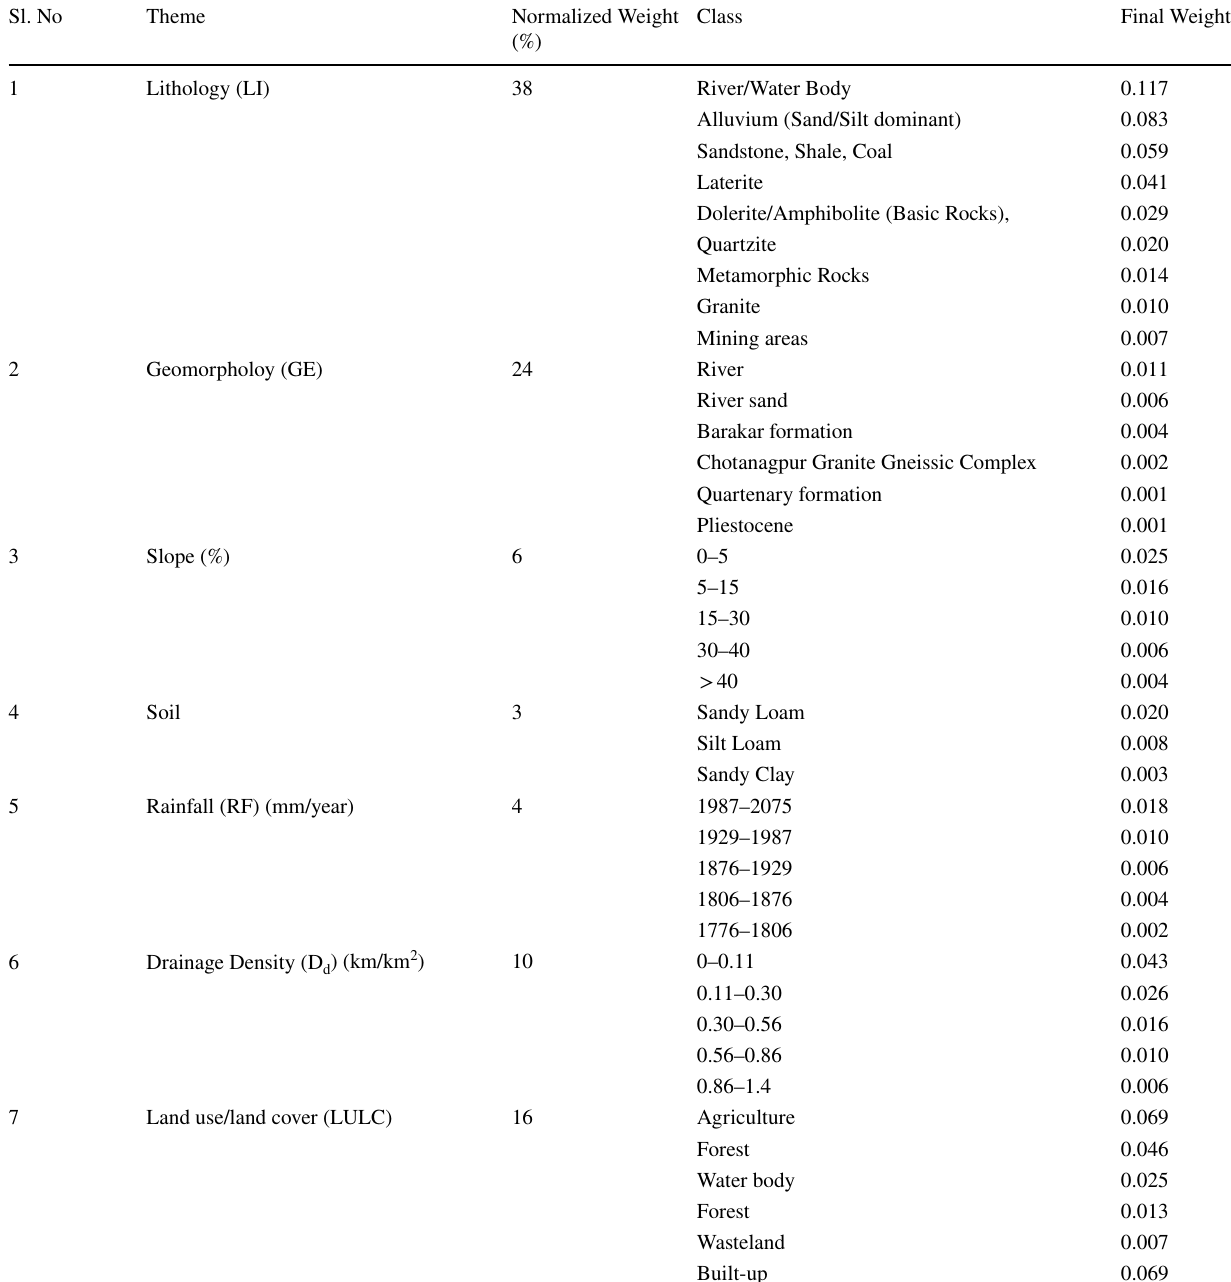
Table 3 Normalized and final weights of different features of eight thematic layers for groundwater prospects Sl.